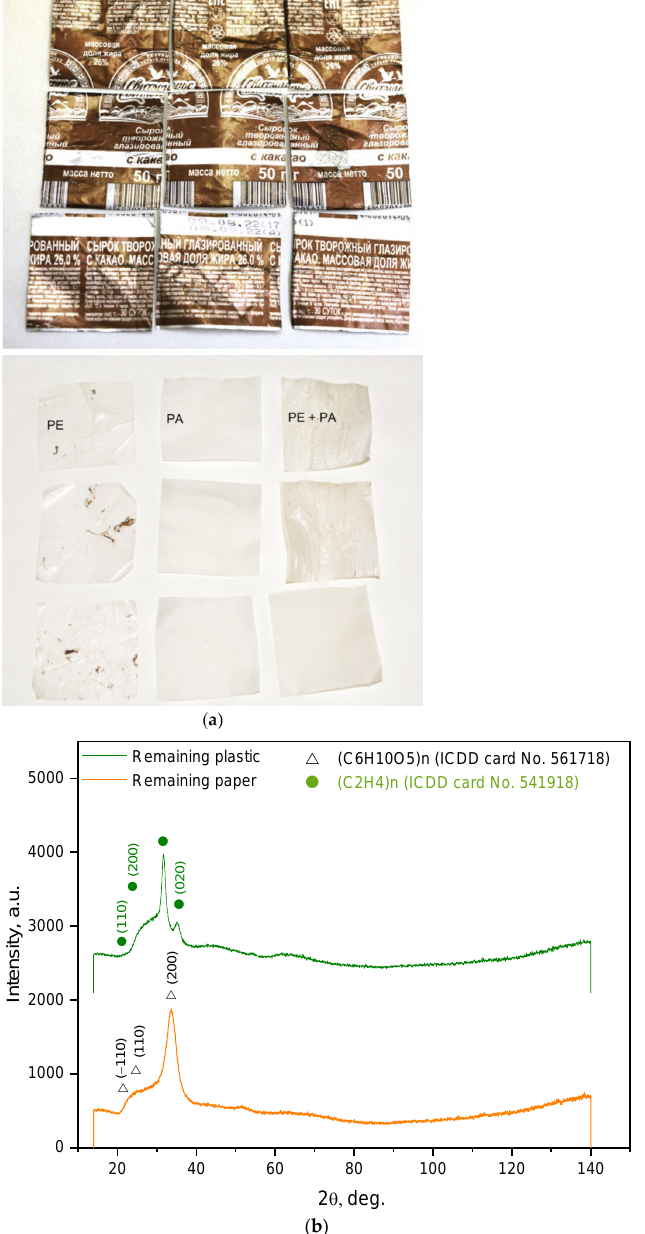
Figure 6. Characterization of the remaining sample components: ( a ) general view (original and residual sheet pieces); ( b ) XRD patterns for the remaining layers.